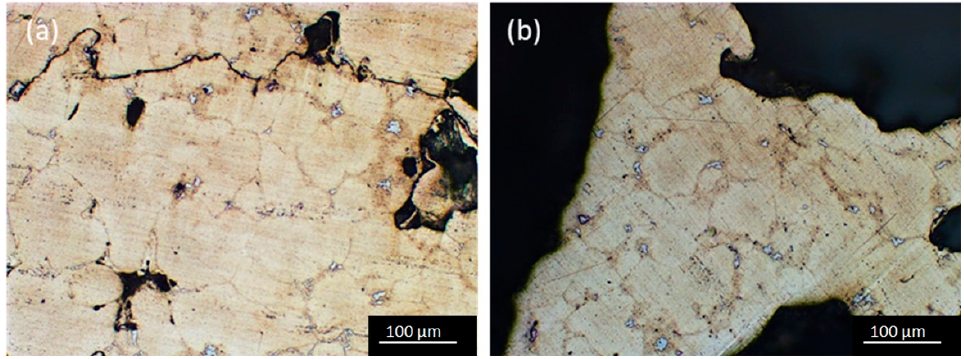
Figure 4. Optical micrograph showing the microstructure of ( a ) the alloy of the external wall and ( b ) the wall between adjacent cavities.